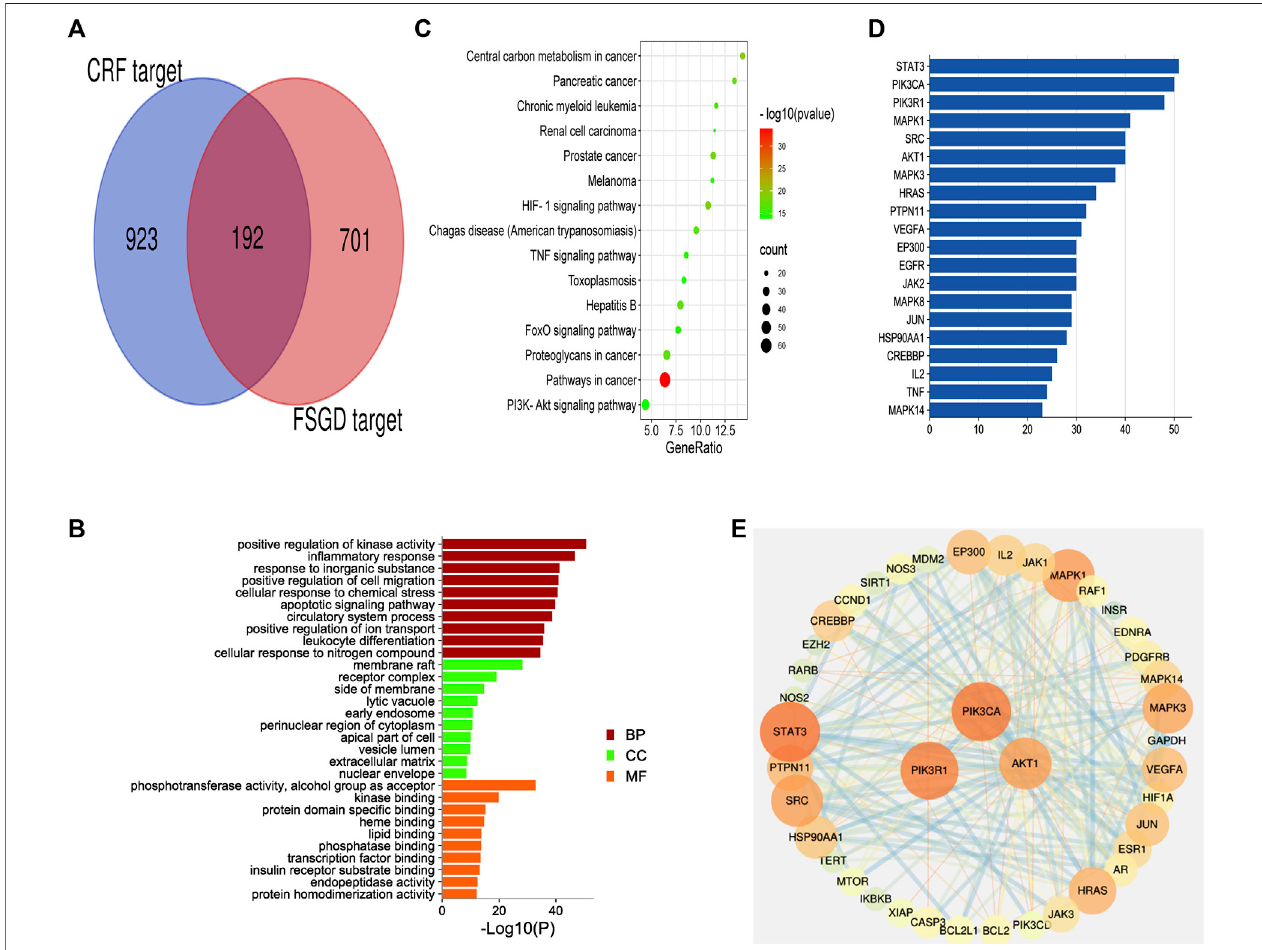
FIGURE 2 | The fi rst dimension-network pharmacology study of FSGD in CRF. (A) Venn diagram of common targets in FSGD and CRF. (B) GO enrichment analysis. X -axis represents the different values of − log10(p). Y -axis represents the name of biological processes. (C) The top 15 KEGG pathway enrichment dot-plot diagram. X -axis represents the ratio of enriched target genes/background genes. Y -axis represents the term of enriched pathways. The sizes of the dots indicate the number of target genes in a certain pathway, and the colors of the dots re fl ect the different values of − log10(p). (D) The construction of protein-protein interaction network. Edges represent protein-protein interactions, edge thickness indicates the strength of data support, the larger the node, the higher the degree value. These circlesrepresentthetargetsthatinteractwithAKT1. (E) Thecommontargets-barplotdiagram. X -axisrepresentsthenumberofnodesconnectedand Y -axisrepresents the target gene